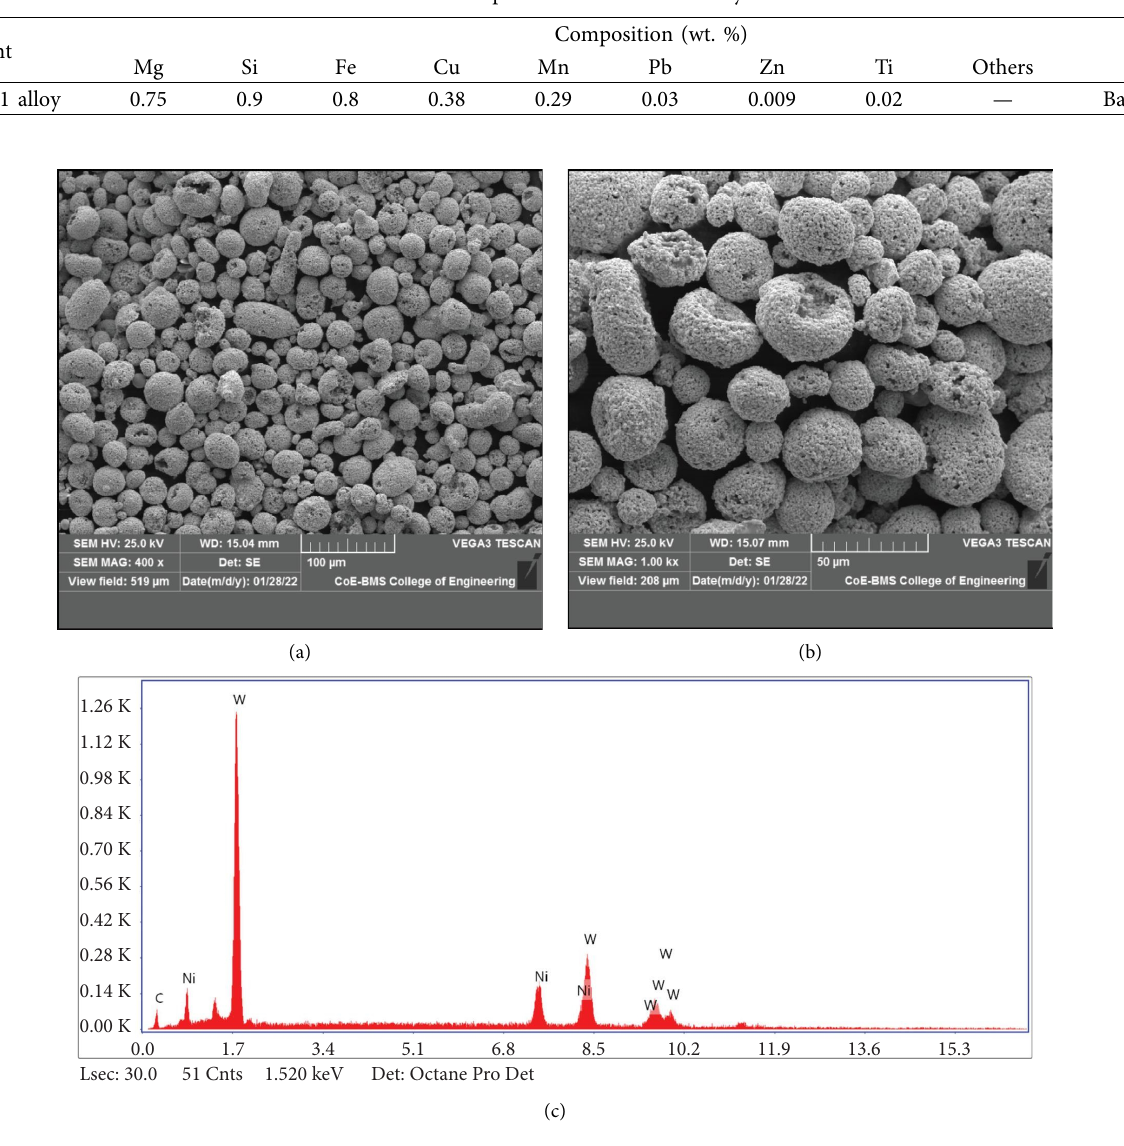
Table 1: Composition of aluminum